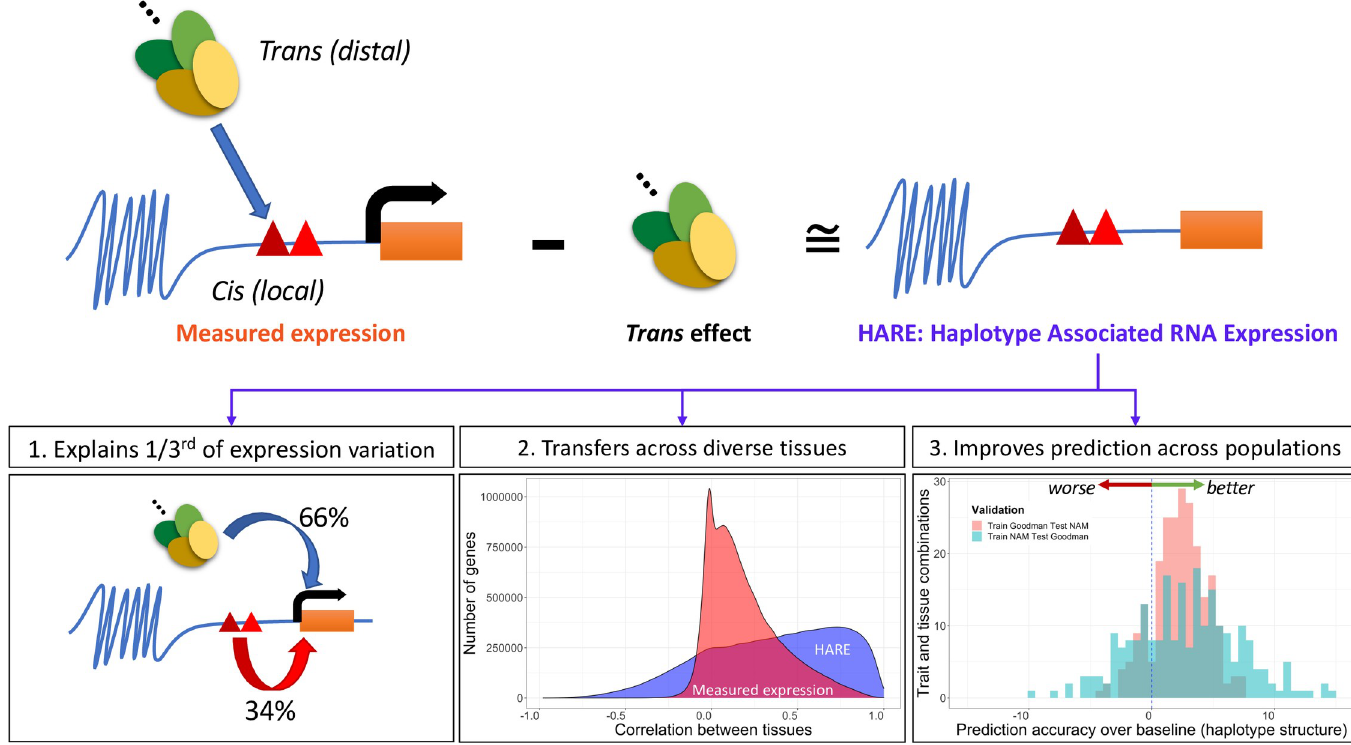
Fig 8. Graphical Summary of the Study. Cis haplotype associated RNA expression (HARE) was obtained from subtracting trans effects from measured expression. 1. The cis haplotypes explained one-third of the variation in expression. 2. The HARE estimates were highly transferable across tissues compared to measured expression. 3. HARE improved prediction within and across populations in maize.